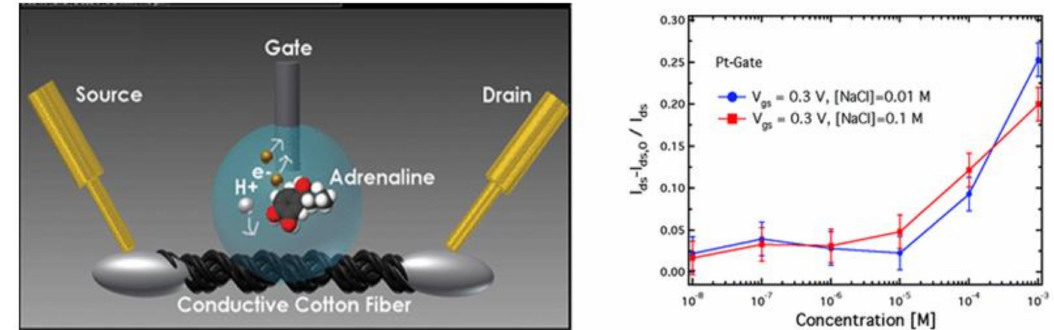
Figure 16. Schematic of the cotton-OECT device with a Pt gate and an adrenaline molecule in its sensing process ( left ). Plots of the normalized transistor response at different concentrations of adrenaline from 10 − 8 to 10 − 3 M, with a Pt-gate electrode at two different NaCl concentrations (10 − 1 and 10 − 2 M) ( right ). Reproduced from [121] with permission of The Royal Society of Chemistry.